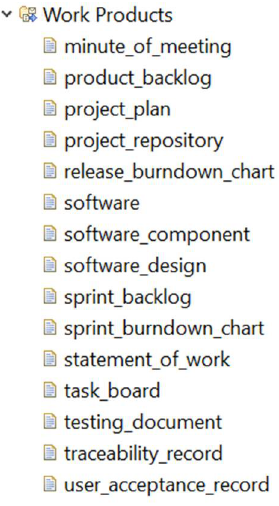
Figure 9. The selected work products from ISO/IEC29110 and Scrum.